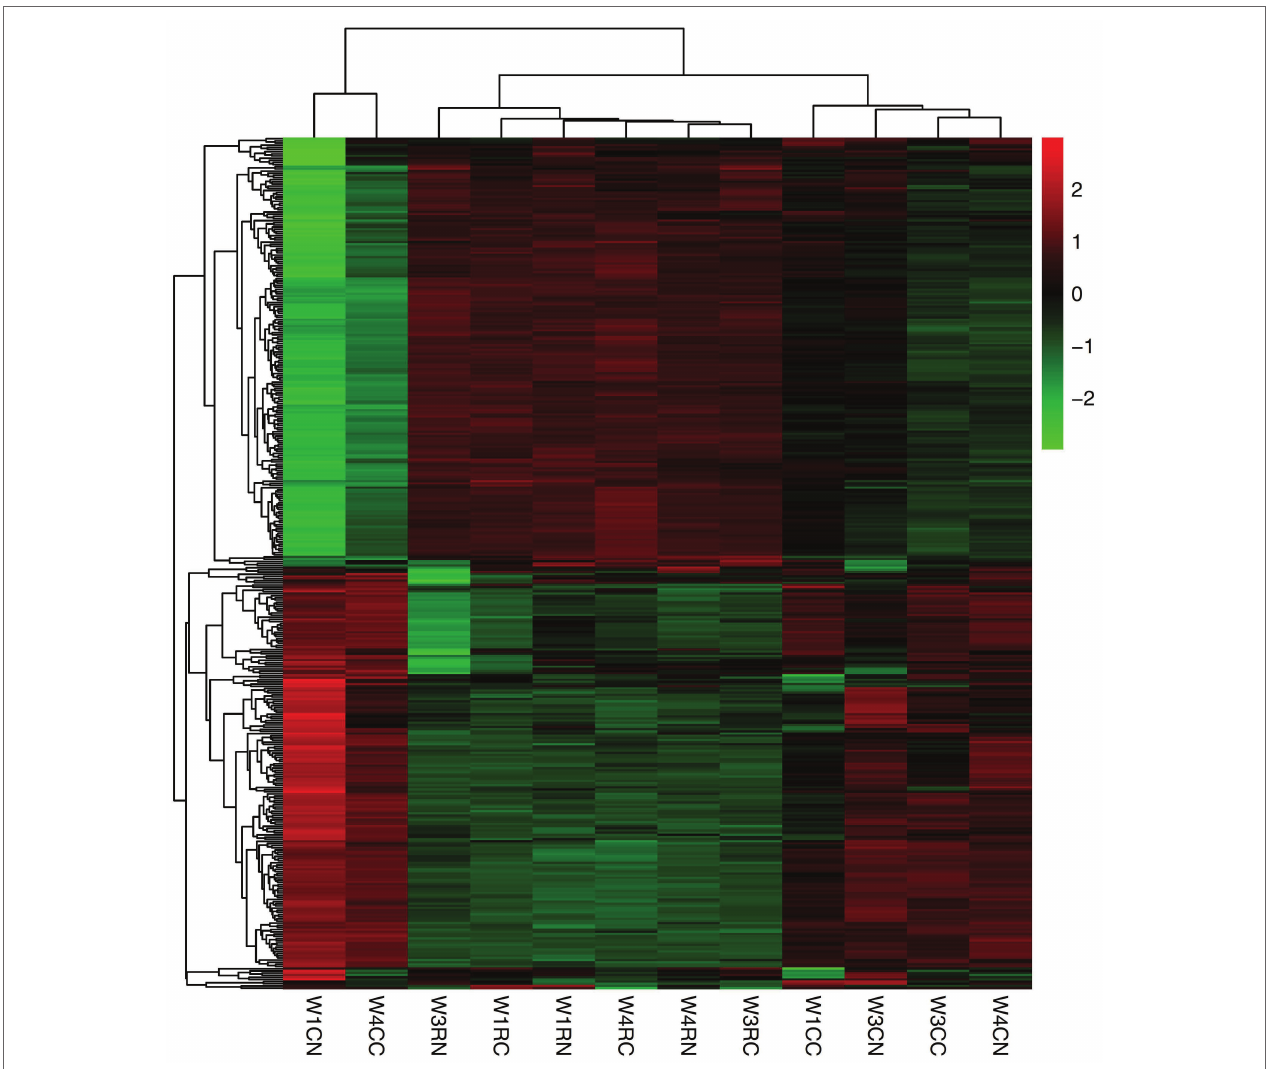
FIGURE 4 | Cluster analysis of differentially expressed mRNAs. Red indicates upregulated mRNAs; green indicates downregulated mRNAs. W1CC is choroid after 7 days of laser photocoagulation, W1CN is another choroid collected from the same tree shrew as W1CC. W3CC and W4CC are choroids after 21 and 30 days of laser photocoagulation, respectively. W3CN and W4CN are choroids collected from the same tree shrews as W3CC and W4CC, respectively. W1RC is retina after 7 days of laser photocoagulation, W1RN is another retina collected from the same tree shrew as W1RC. W3RC and W4RC are retina after 21 and 30 days of laser photocoagulation, respectively. W3RN and W4RN are retina collected from the same tree shrews as W3RC and W4RC,